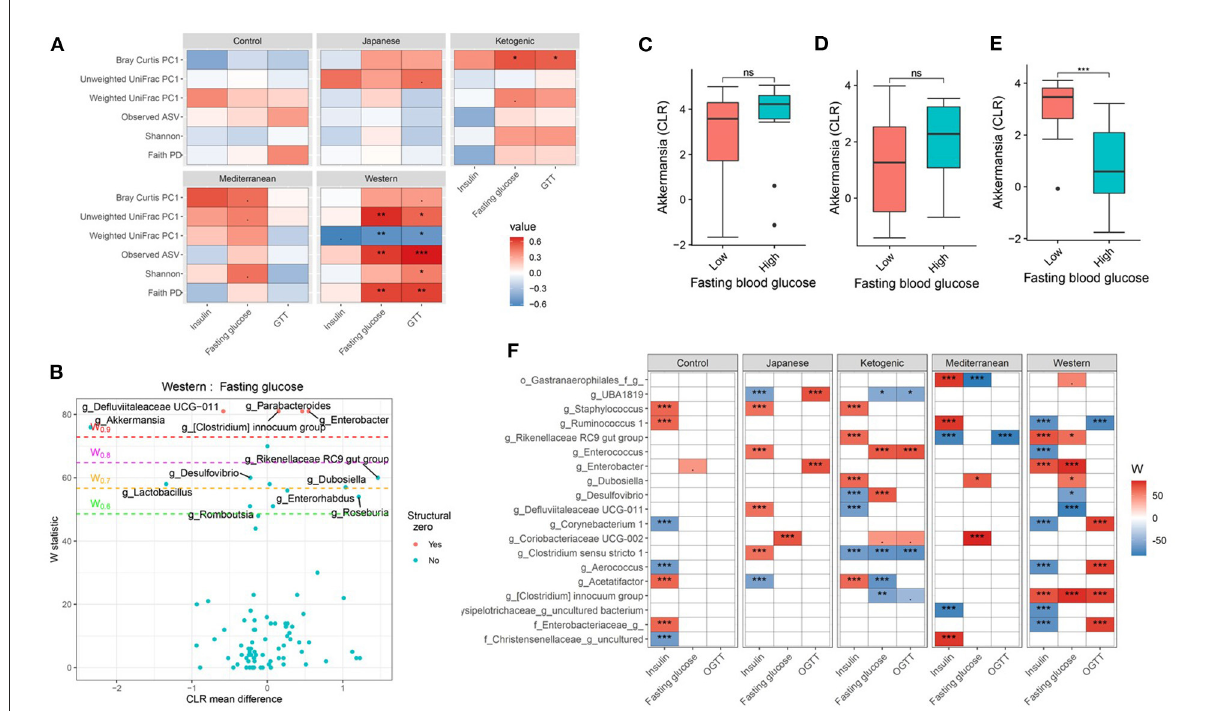
FIGURE4 Diet and gut microbiota interact to modulate host’s glucose metabolism. (A) Association between fasting blood glucose parameters and α -diversity or first principal component (PC1) of β -diversity measured for each diet determined by using Spearman correlation. As indicated, red represents a positive correlation and blue represents a negative correlation. P-values were adjusted for multiple comparisons using BH method. “***” = adj. p < 0.001, “**” = adj. p < 0.01, “*” = adj. p < 0.05, and “.” = adj. p < 0.10. (B) Volcano plot of the differential genera abundance between high (above median) and low (below median) fasting blood glucose in mice maintained on western diet determined by ANCOM analysis. Structural zero represents the presence of the bacteria in one group and the complete absence in another group. (C–E) Relative abundance of the Akkermansia in mice with high (above median) and low (below median) fasting blood glucose levels in mice maintained on the (C) KD, (D) MeD, and (E) WD. Mean abundance was compared using the Wilcoxon rank-sum test. For (C–E) , “***” = p < 0.001, and “ns” = not significant. (F) Differential genera abundance between high (above median) and low (below median) glucose metabolism parameters determined by ANCOM analysis. 20 most differentially abundant (based on cumulative ANCOM W-value) were selected for the graph. For easier presentation, ANCOM W values were converted to negative if CLR effect size is negative. Red indicates higher genera abundance in the above-median group and blue bacteria represents higher genera abundance in the below-median group. White represents a non-significant result obtained from ANCOM analysis. Models were adjusted for mouse strain and sex as confounding factors. ANCOM models were FDR (BH-method) corrected for multiple comparisons and a significant sub-hypothesis test at level adj. P < 0.05 was counted toward the W value. The median was calculated for each diet. For (F) , “***” = ≥ W 0.9 , “**” = ≥ W 0.8 , “*” = ≥ W 0.7 , and “.” = ≥ W 0.6